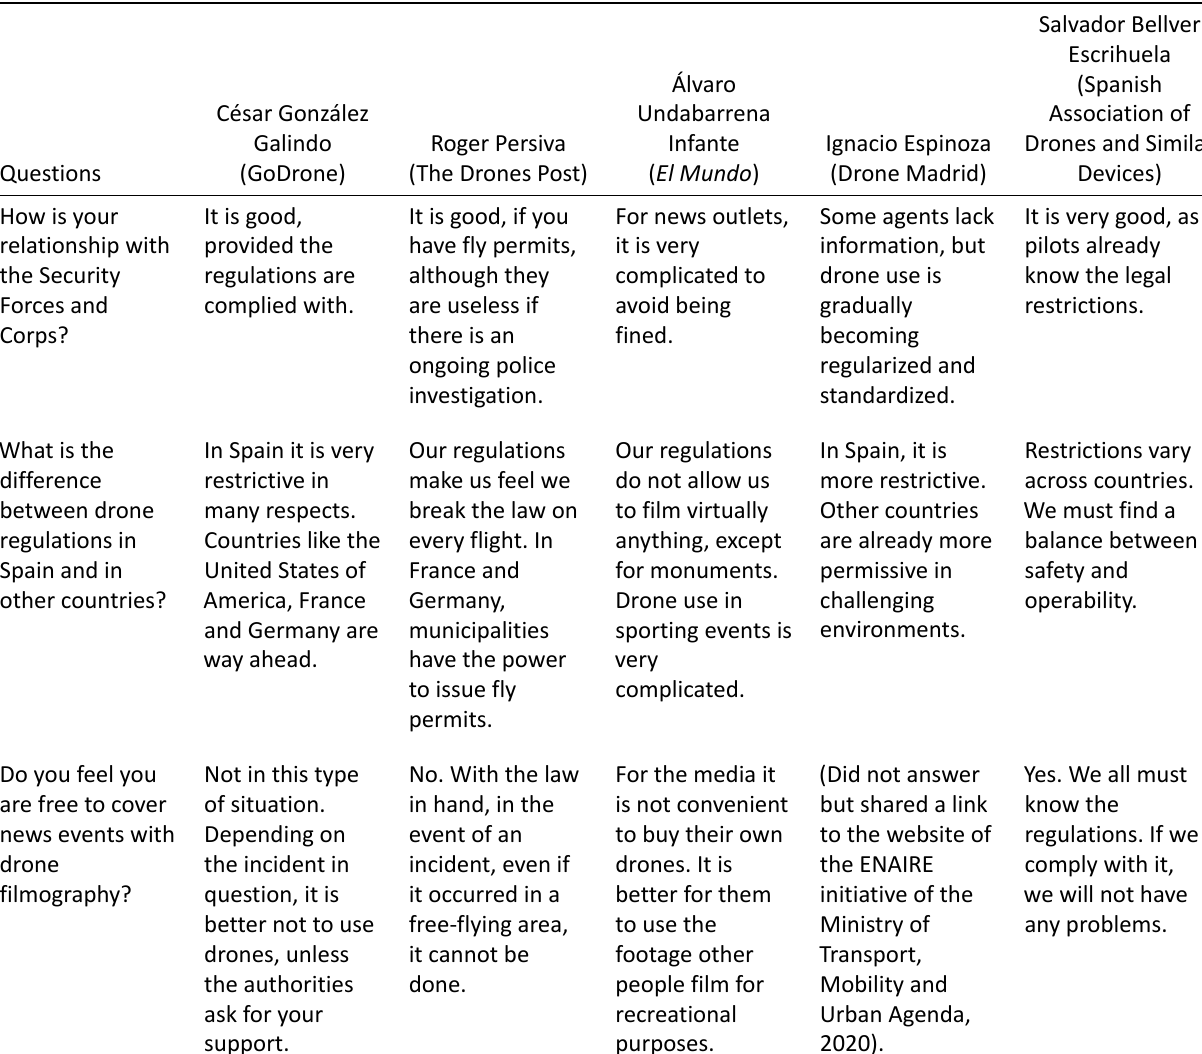
Table 4. Summary of answers provided by the panel of experts representing drone pilots working for the